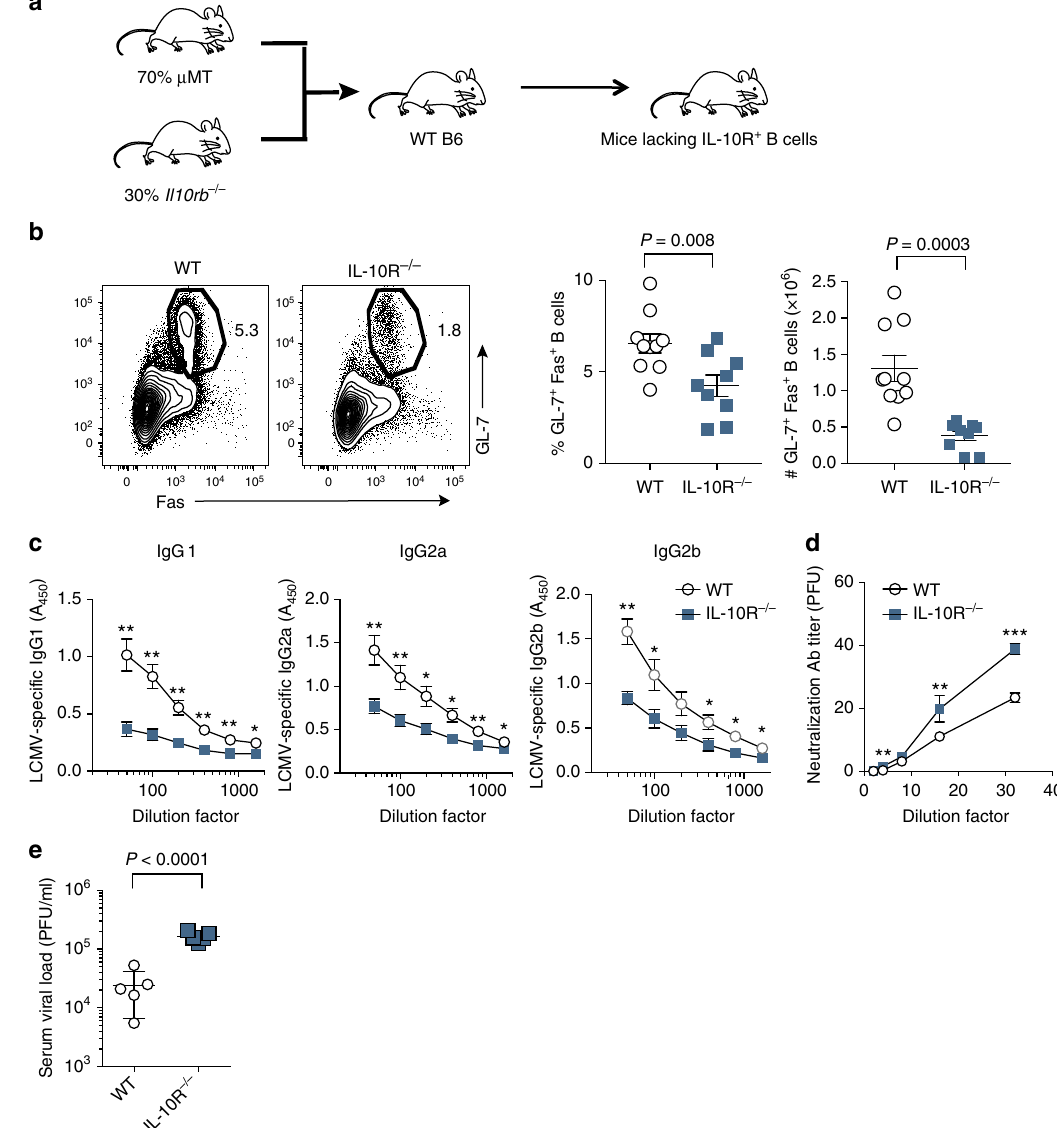
Fig. 5 B cell-intrinsic IL-10 signaling is essential for maintaining GC reactions. a Experimental scheme of generating MBM chimeric mice with B cell-speci fi c Il10r deletion. b – d WT and Il10r − / − B cell MBM chimeric mice were infected with LCMV Cl13 and B cell responses were examined on day 21 p.i. b Representative fl ow plots (left) and scatter graphs (right) showing the frequency and total number of GC B cells from WT and Il10r − / − MBM chimeric mice. c Summary graphs showing serum levels of LCMV-speci fi c IgG1, IgG2a, and IgG2b. d Summary graph showing relative antibody neutralization titers for control and Il10r − / − B cell MBM chimeric mice. e Serum viral titers from WT and Il10r − / − mice as determined by plaque assay. Summary data (mean + /- SEM in b – e ) are pooled from two independent experiments with 4-5 mice/group per experiment. * P < 0.05, ** P < 0.01, *** P < 0.0001. Data